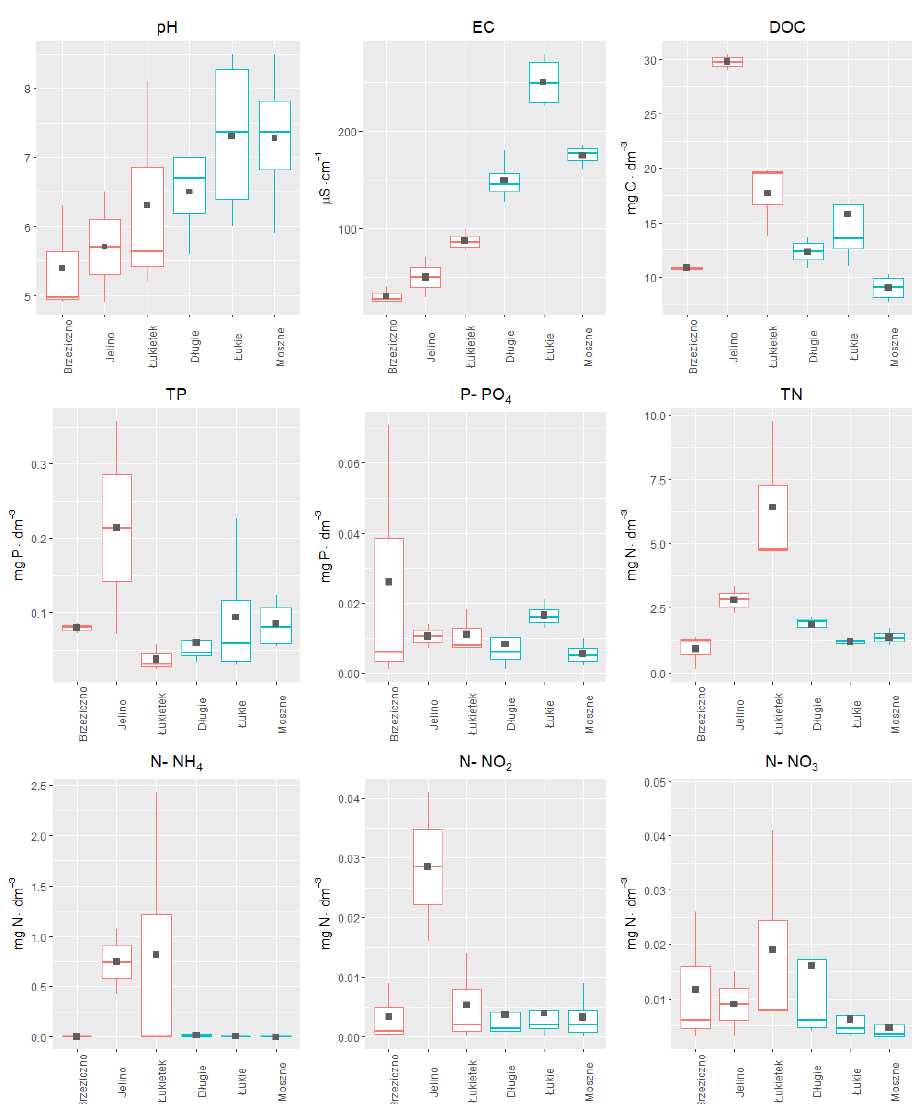
Figure 10. Distribution of values of the investigated physical–chemical factors of water at the study sites in 2019. The mean value of the data is marked by a filled square. The lakes with aldrovanda populations are marked in blue, and the reservoirs taken into account as substitute habitats for the species are marked in red.